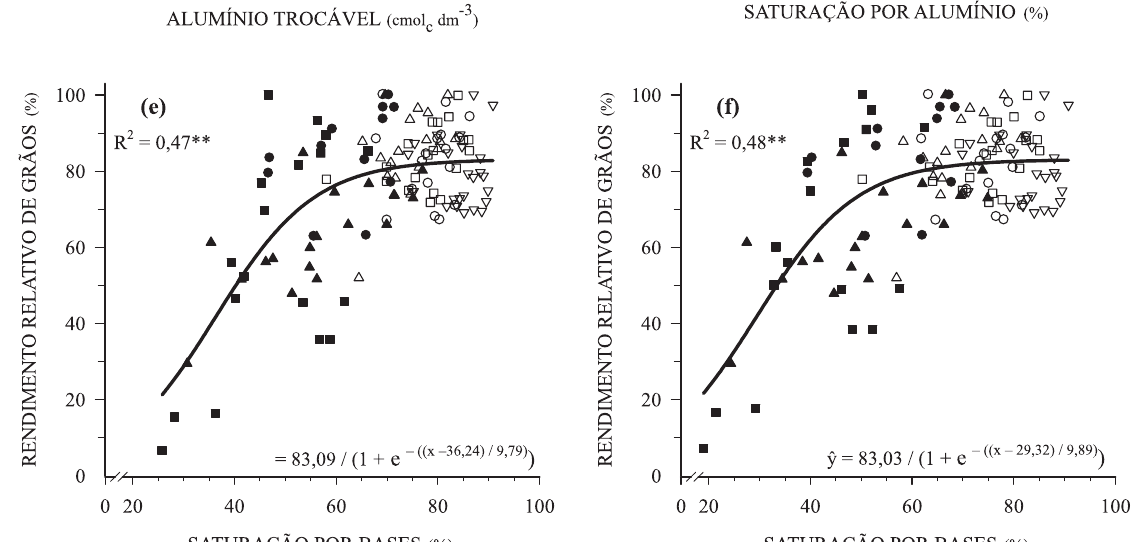
Figura 2. Relação entre o rendimento relativo de grãos e os indicadores de acidez do solo na camada de 0 a 10 cm de profundidade em lavouras no sistema plantio direto: (a) pH em água; (b) pH em CaCl alumínio trocável; (d) saturação por alumínio e saturação por bases; (e) Eq. Escosteguy & Bissani (1999) e (f) Eq. Kaminski et al.